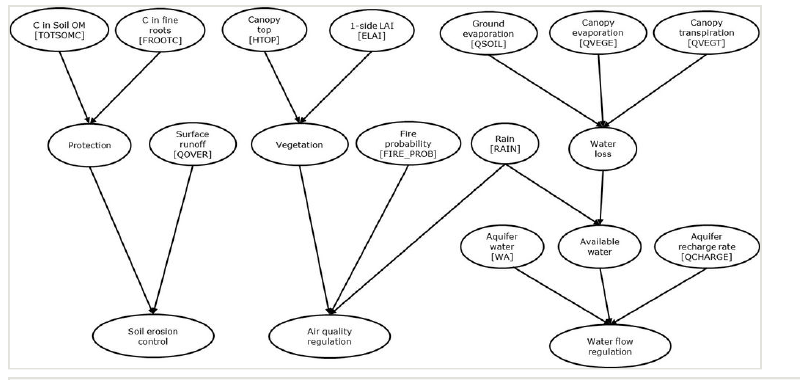
Schematic representation of the BN built for the assessment of the selected ES (Soil erosion control, Air quality regulation, Water fl ow regulation). Bio-physical components from the CLM are indicated within square brackets []. See Table 1 for their de fi nition and see the main text for a description of each relevant